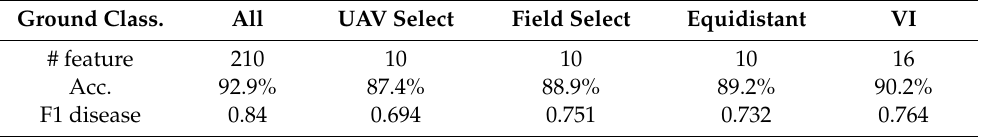
Table 4. Performance of the di ff erent feature sets for the YR detection based on ground observations. Ground Class.